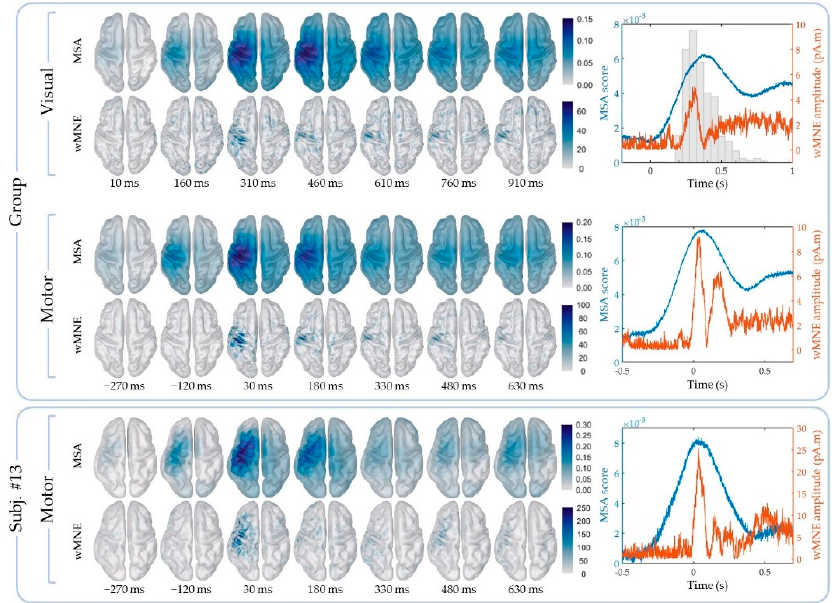
Figure 3. “FingerTap” experiment: (Left) Cortical mapping of the absolute values calculated using the multi-sensor space–time–frequency analysis (MSA) (upper rows) and the weighted minimum norm estimate (wMNE) method (lower rows). (Right) Time course of the mean absolute value in the Lmot region using the MSA (blue curve) and the wMNE method (orange curve). The additional histogram in the top-right plot indicates the participants’ response time after visual cue. The results shown correspond to the group-level calculations (upper frame) and to a specific subject for illustration (subj. #13, lower frame).